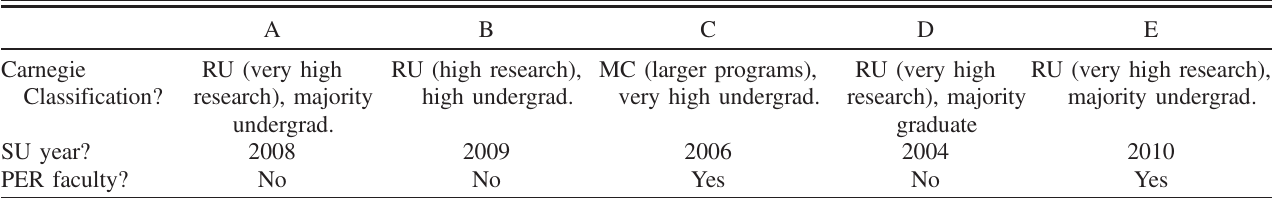
TABLE III. Institutional profiles based on Carnegie Classification, all institutions are full time, 4-year institutions with a student population ranging from 7000-27 000. A Research University (RU) is classified as such based on research expenditures, the number of research doctorates awarded, the number of research faculty, etc. A Master ’ s College (MC) is defined by the Carnegie Classification as an institution awarding at least 50 master ’ s degrees but fewer than 20